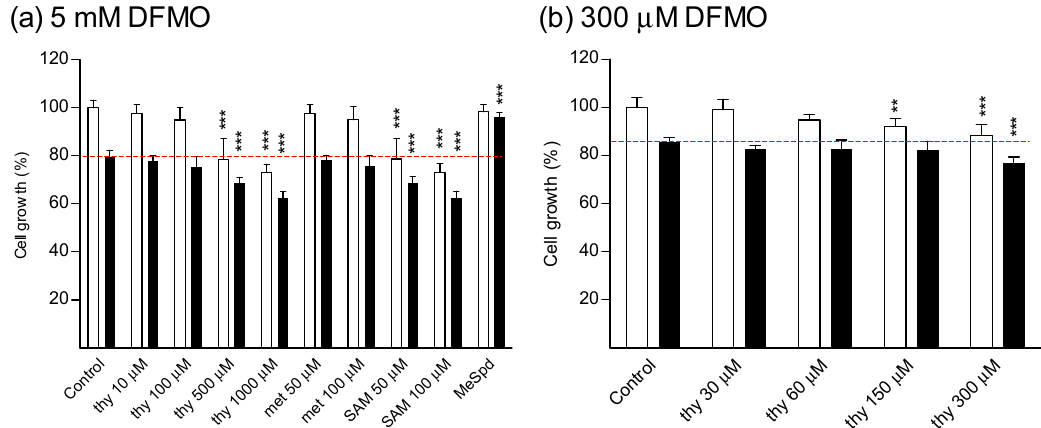
Figure 5. Effect of thymidine, L -methionine, SAM, and ( S )-1-MeSpd on the growth of HT-29 colon carcinoma cells. ( a ) The cells were treated with thymidine (thy, 100–1000 μ M), L -methionine (met, 50–100 μ M), SAM (50–100 μ M) or ( S )-1-MeSpd (MeSpd, 100 μ M) in the presence (black bars) or absence (white bars) of 5 mM DFMO for 4 days. ( b ) The cells were treated with thymidine (thy, 30–300 μ M) in the presence (black bars) or absence (white bars) of 300 μ M DFMO for 4 days. Data are means ± SD, n = 6. **, and *** refer to statistical significance of p < 0.01 and p < 0.001 as compared to control/DFMO groups, respectively. The red dotted line indicates the level of cell growth of DFMO-treated cells.